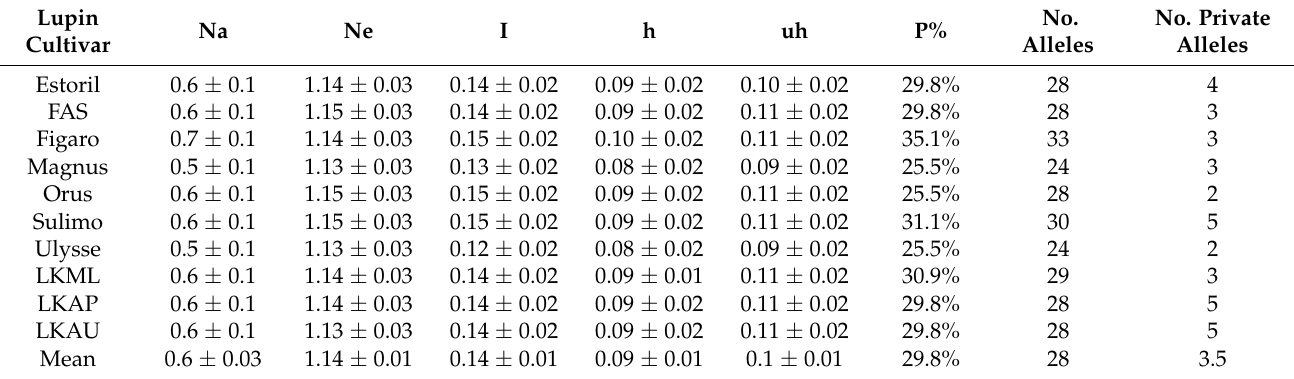
Table 8. Genetic polymorphism indices of the 10 lupin